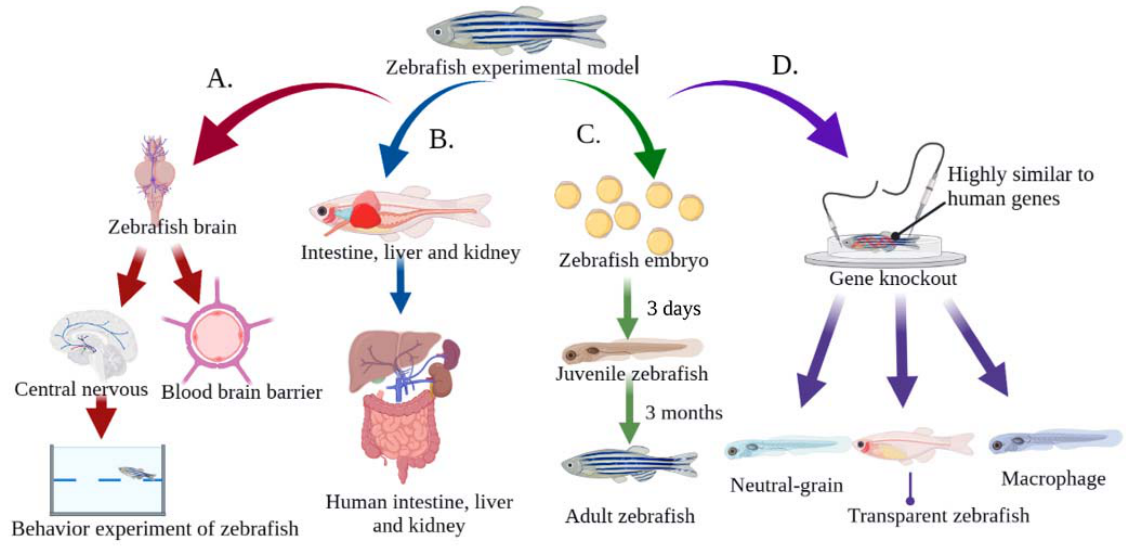
Figure 2. Advantages of zebrafish for toxicity evaluation of MNPs. ( A ) The blood–brain barrier, central nervous system, and social behavior are similar to those of humans, making it an ideal animal model for studying neurotoxicity; ( B ) The intestine, liver and kidney are similar to those of humans, which makes them suitable for studying MNPs metabolism and immune diseases; ( C ) The reproductive and developmental toxicity of MNPs can be easily studied due to the short reproductive cycle of zebrafish and the large number of eggs laid. In addition, the embryos are transparent, so a microscope can be used to observe the cell division and organ formation process; ( D ) The genome of zebrafish has been fully sequenced, and is highly consistent with the human genome, and can be easily manipulated by genetic manipulation such as gene knockout and gene